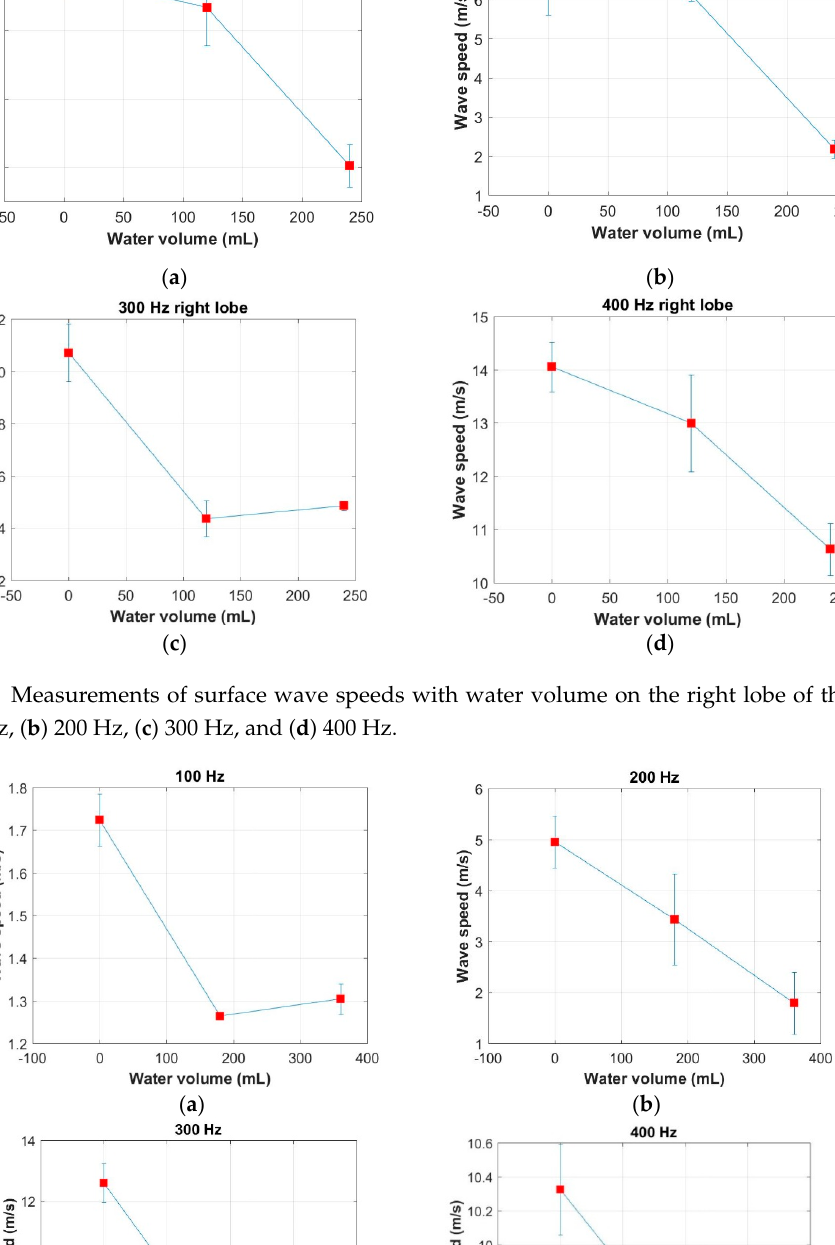
Figure 3. Measurements of surface wave speeds with frequency on the right lobe of the lung. ( a ) 0 mL, ( b ) 120 mL, and ( c ) 240 mL.